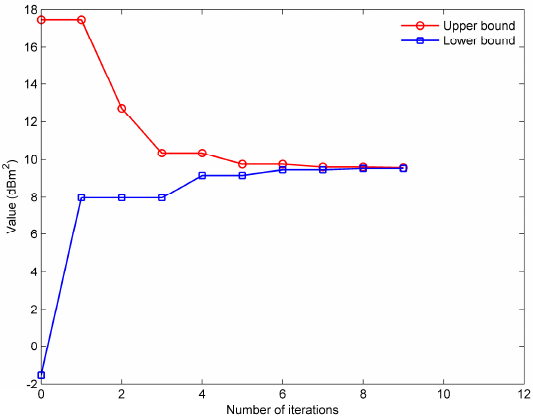
Figure 6. The curves of the upper and lower bounds vary with iteration times.